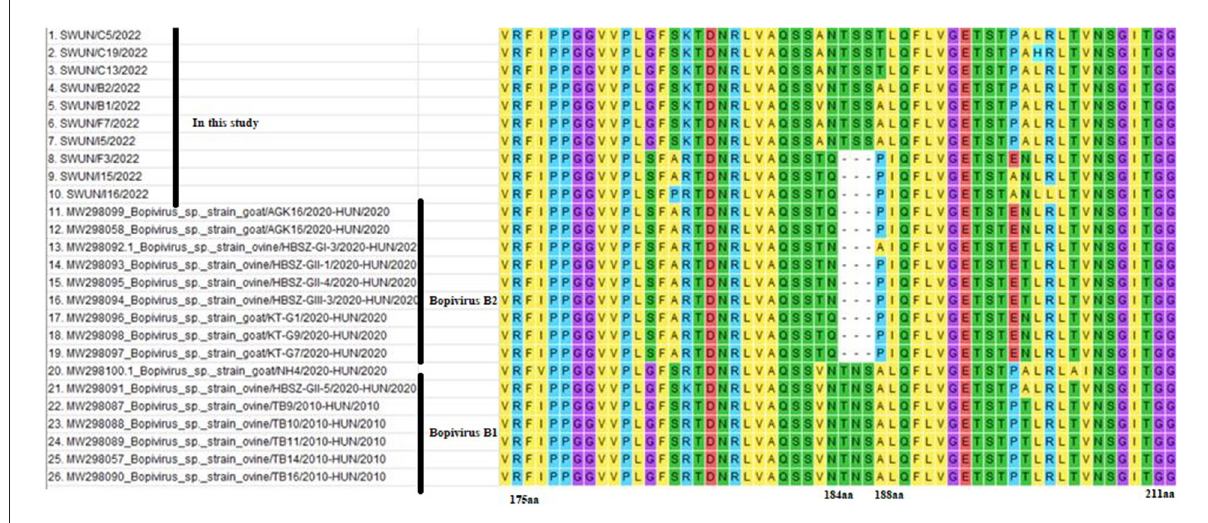
FIGURE2 Amino acid variants of VP1 protein from different “Bopivirus B” strains. Clustal W was used to performed sequence alignments in MEGA 7.0 software.